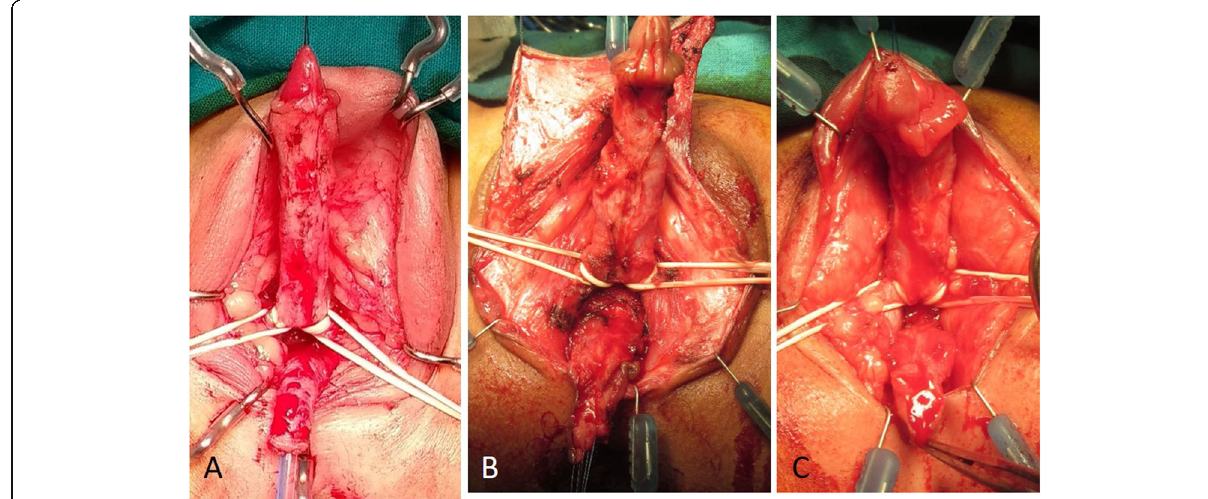
Fig. 3 Feminizing genitoplasty (cont.). a – c Three different cases of CAH (46, XX, a normal female sex chromosomes); their age was 8 months, 84 months and 15 months, respectively. A rubber tourniquet is applied at the base of each of the dorsal corporeal bodies to control bleeding